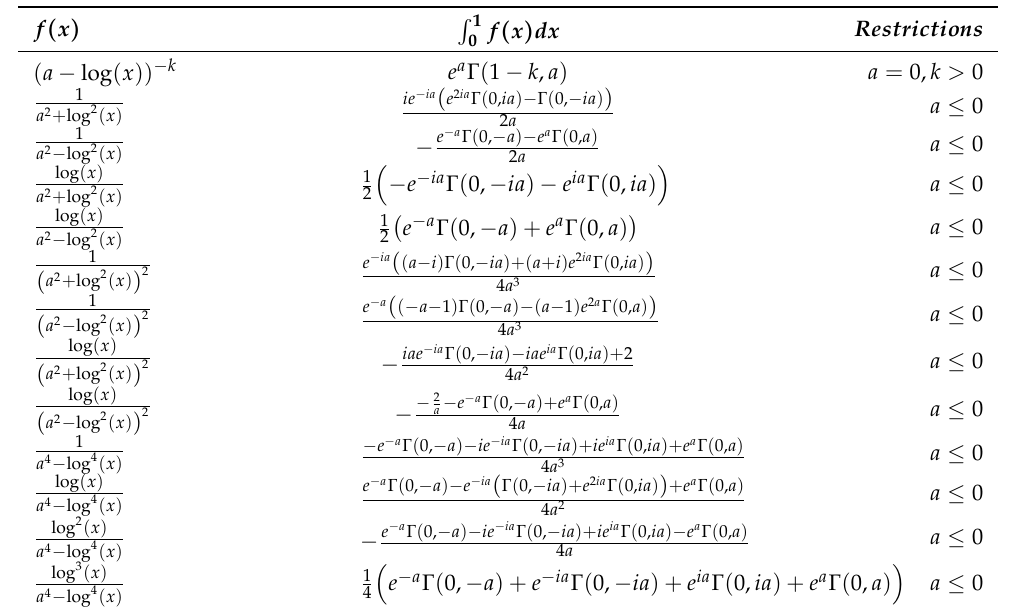
Table 2. Table of definite integrals in Gradshteyn and